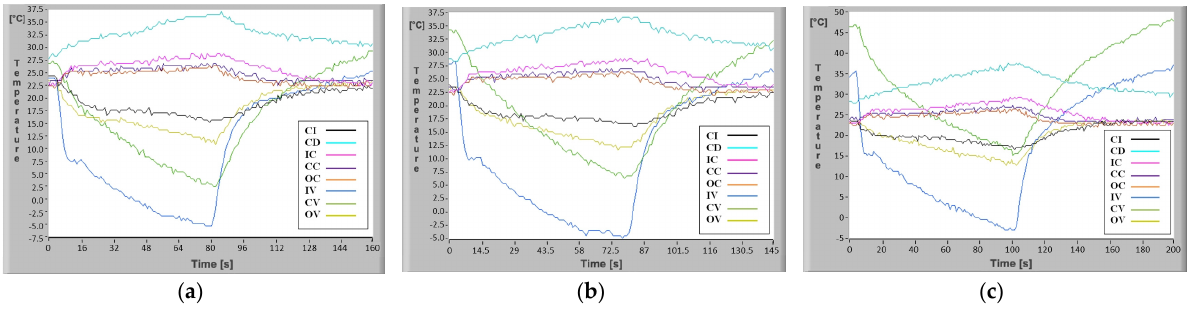
Figure 16. Temperature evolution in rectangular microchannels of the mini refrigeration unit for electrical resistors in the central area of the evaporator heated to ( a ) 26 °C, ( b ) 34 °C, and ( c ) 47 °C.